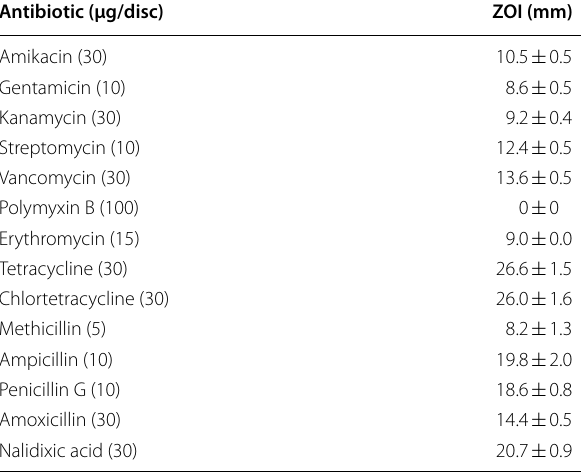
Table 1 Antibiotic sensitivity of AJK3 strain